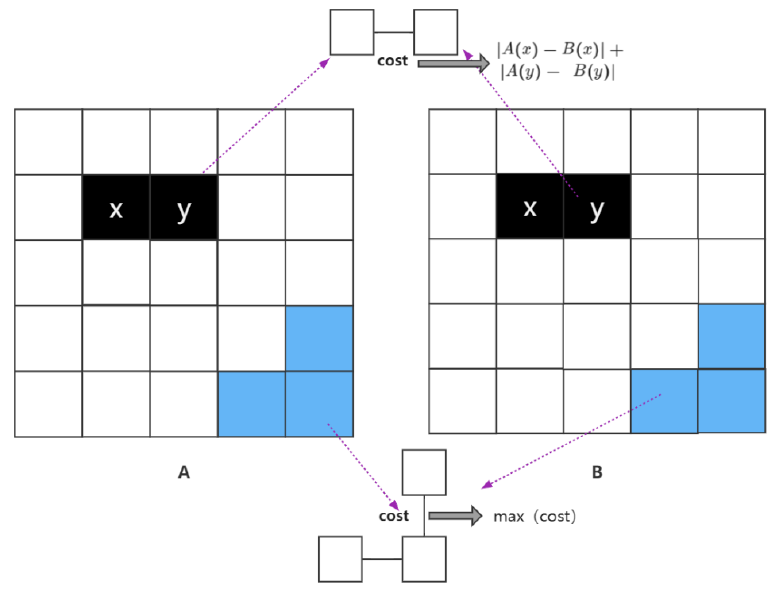
Figure 2. Example diagram of network flow establishment. The black part uses the internal element assignment method, and the blue part uses the edge element assignment method.